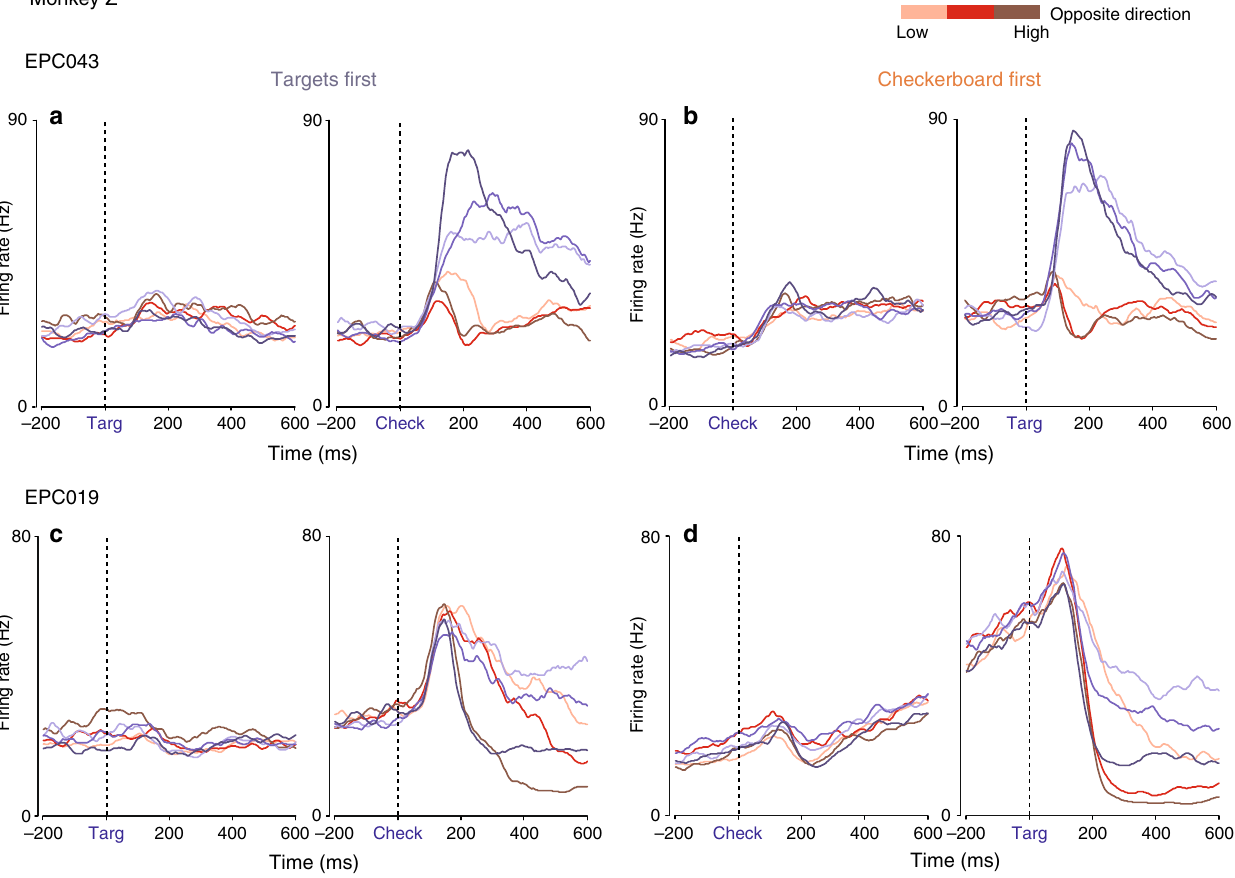
Fig. 3 Example units with responses to the fi rst visual cues of each task. See also Supplementary Figure 2. a , b Unit EPC043 emitted a transient increase in activity detected at 160 ms after the Targets appeared in the TF task ( a ), and a stronger sustained response beginning 140 ms after the appearance of the checkerboard in the CF task ( b ). c , d Unit EPC019 emitted a small rise in activity that was detected at 240 ms after Targets appearance in the TF task ( c ). In the CF task ( d ), there was a brief increase in activity detected at 140 ms after the appearance of the checkerboard, followed by a transient suppression